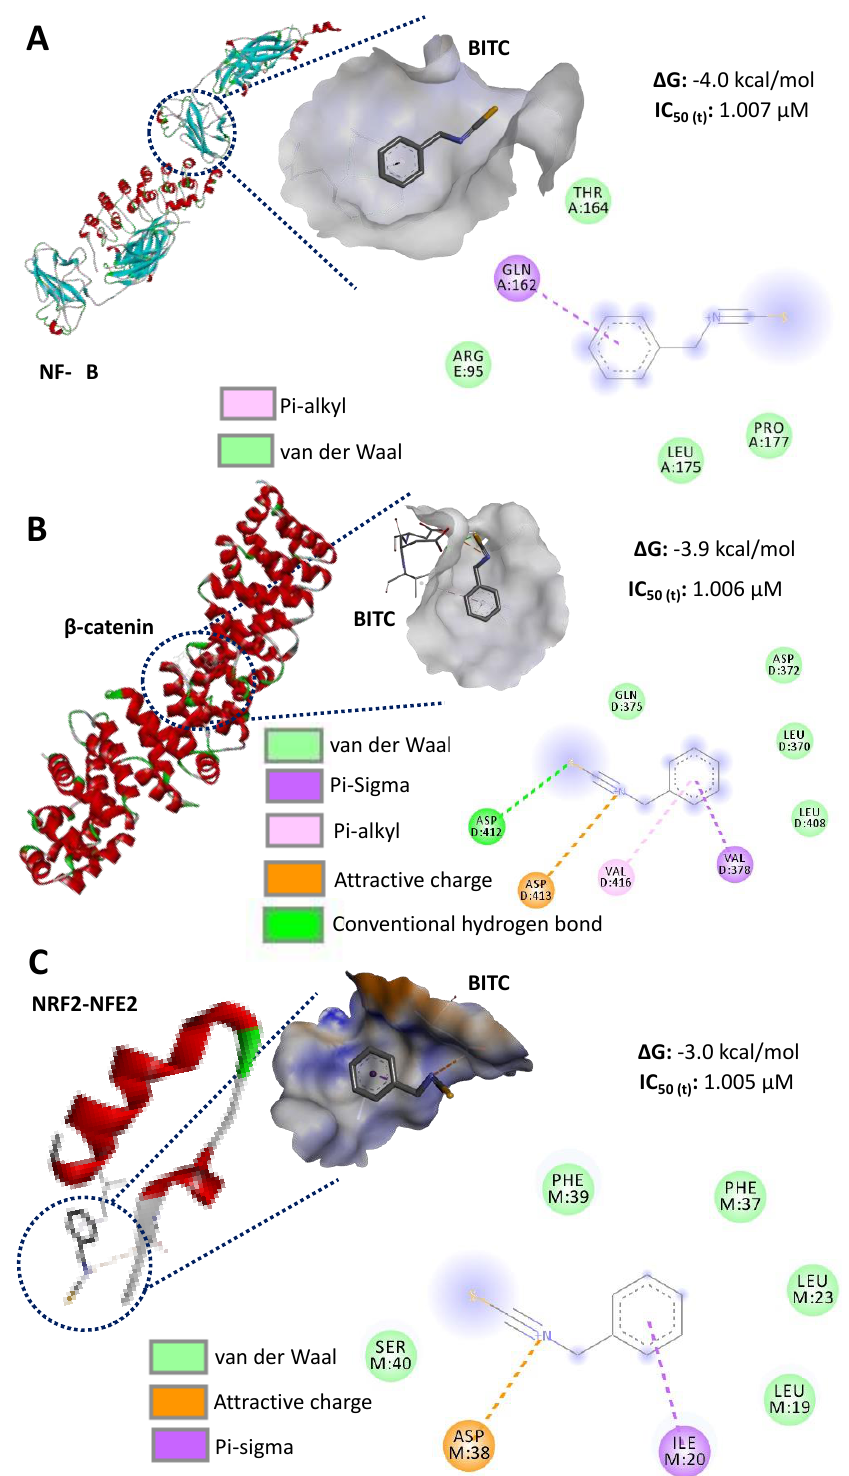
Figure 6. In silico inhibition evaluation of the binding affinity between benzyl isothiocyanate (BITC) and molecular targets of colorectal cancer cells. ( A ) Binding between BITC and nuclear factor κ B (NF- κ B); ( B ) binding between BITC and β -catenin; ( C ) binding between BITC and NRF2-NFE2. ∆ G: Gibbs free energy; IC 50 (t) : theoretical half-inhibitory concentration (calculated using ∆ G).